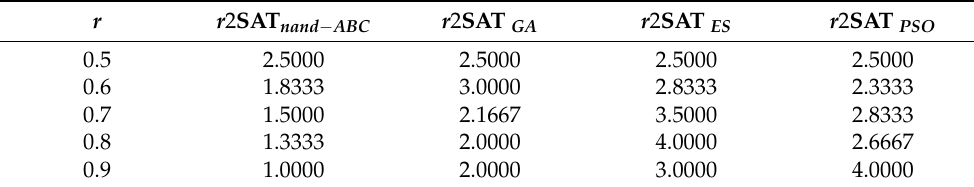
Figure 6. Convergence Curve for each Algorithms. Table 19. Av R of all algorithms in the logic